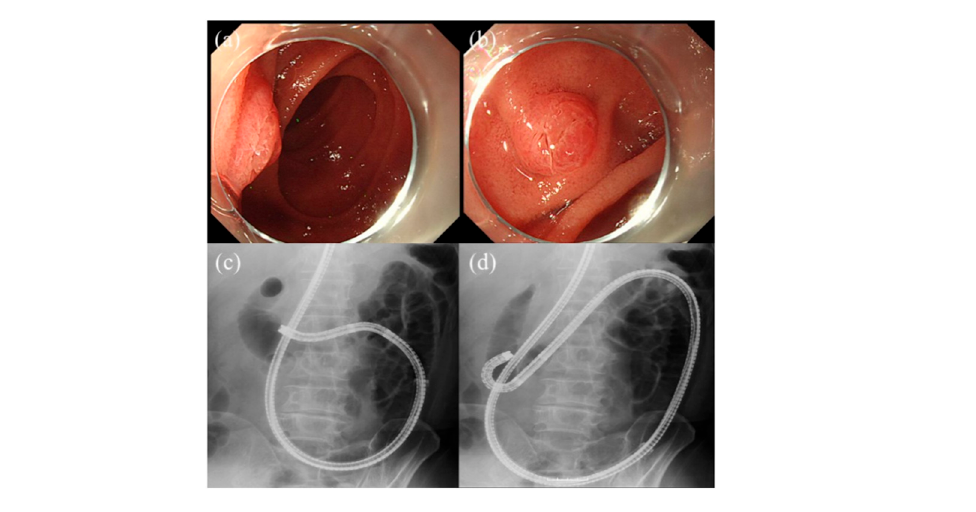
Figure 2. Retroflex position: ( a , c ). The papilla is positioned tangential, so it is difficult for biliary cannulation. ( b , d ) The endoscope is advanced while using the up angle at the inferior duodenal angle. As a result, it provides a better view of the papilla.